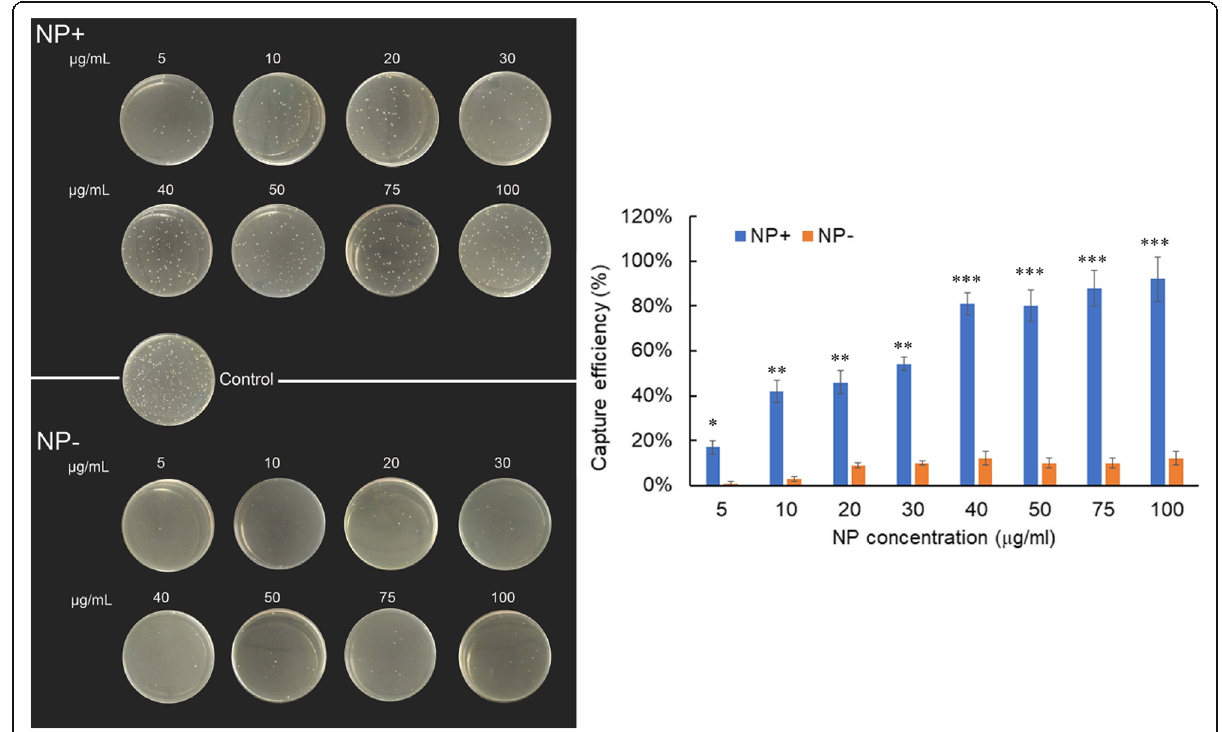
Fig. 6 Capture efficiencies of E. coli by NP+ or NP − at various concentrations indicated. The left image is the photograph of LB-agar plates coated with E. coli captured by NP+ and NP − . The right image shows the bacterial capture efficiency of NP at different concentrations indicated. E. coli (2 × 10 2 CFU in 1 mL PBS solution) without NP incubation was counted as 100% and served as control. * P < 0.05, ** P < 0.01, *** P <